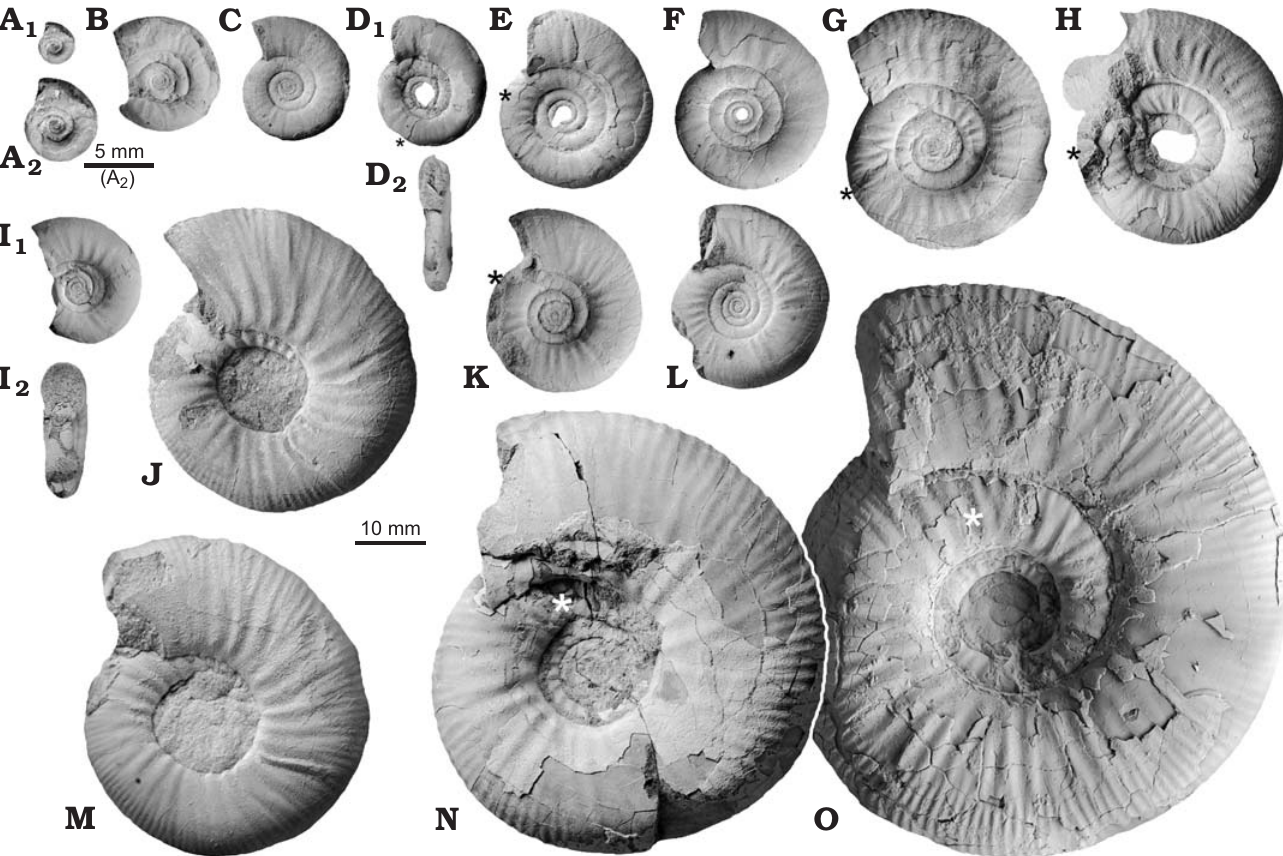
Fig. 5. Morphoceratid ammonite Polysphinctites tenuiplicatus (Brauns, 1865) [M] and [m] showing successive growth stages, Lower Bathonian, Polysphinctites tenuiplicatus Zone, Polish Jura, Kawodrza Górna (A–N) and Faustianka (O). A . GIUS 8-2592, juvenile with beginning of body chamber; natural size (A 1 ), enlargement (A 2 ). B – H . Microconchs, males. B . GIUS 8-2590. C . GIUS 8-2594. D . GIUS 8-2611, lateral (D 1 ) and apertural (D 2 ) views. E . GIUS 8-2646. F . GIUS 8-2593. G . GIUS 8-2640. H . GIUS 8-2622. I – O . Macroconchs, females. I . GIUS 8-2608, lateral (I 1 ) and apertural (I 2 ) views. J . GIUS 8-2703. K . GIUS 8-2687. L . GIUS 8-2717. M . GIUS 8-2710. N . GIUS 8-2733. O . GIUS 8-2715. H, O, examples of complete adult specimens with peristome. The asterisks indicate the last septum. All natural size, except A 2